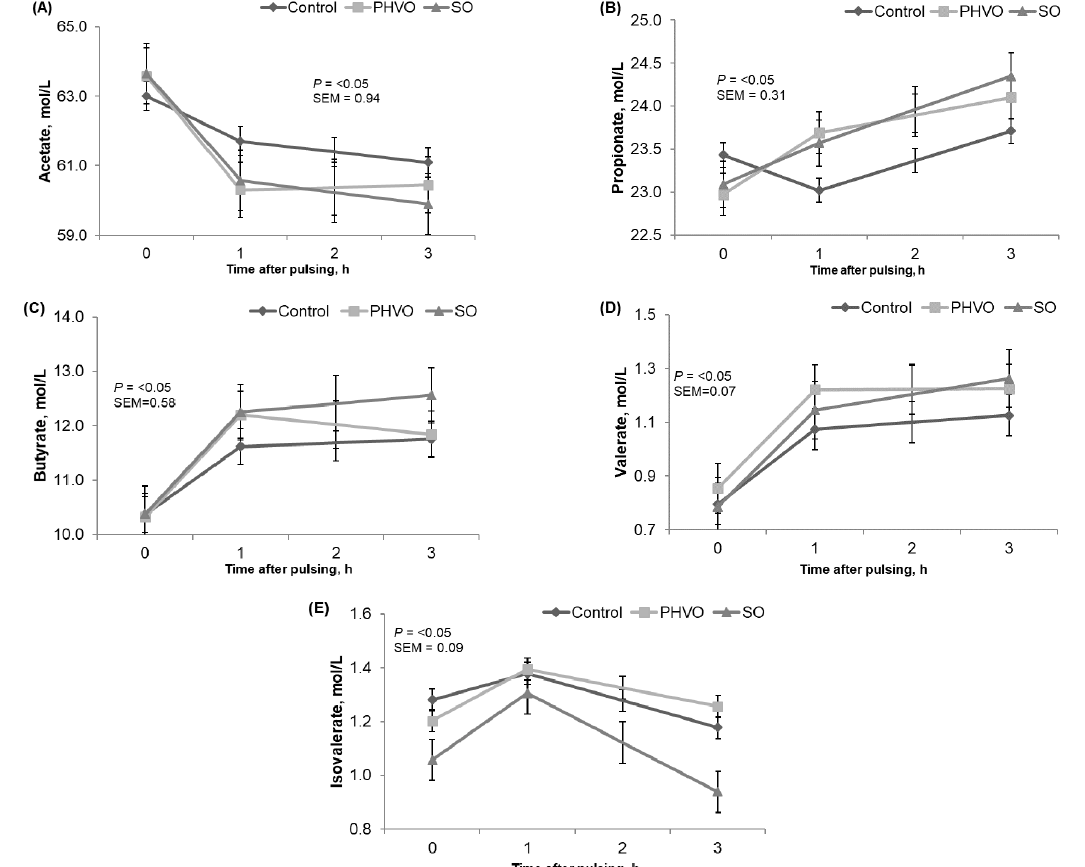
Figure 1. Time variations of volatile fatty acids from cows subjected to ruminal pulses of control, partially hydrogenated vegetable oil (PHVO) and soybean oil (SO). ( A ) Acetate; ( B ) propionate; ( C ) butyrate; ( D ) valerate and ( E ) isovalerate. Ruminal fluid samples were collected prior to ruminal pulse (0 h; 09:00) and at 1 and 3 h after ruminal pulse (10:00 and 12:00). SEM = standard error of the mean. Probability of p < 0.05 was used to determine significant differences between means. Means are pooled across days for each cow. p ‐ value represents the effect of sampling time.